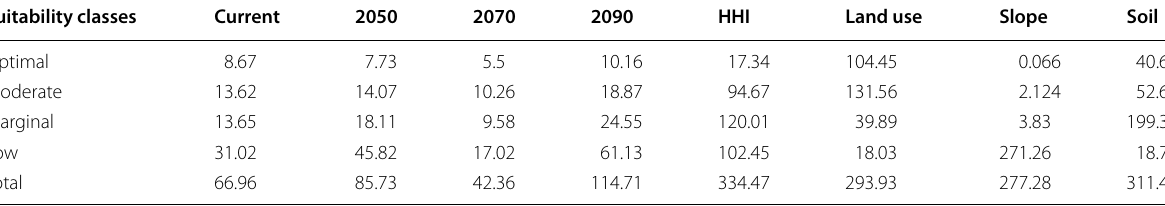
Table 7 Area ( 10 4 km 2 ) of each habitat suitability class with studied bioclimatic and non-bioclimatic variables ×